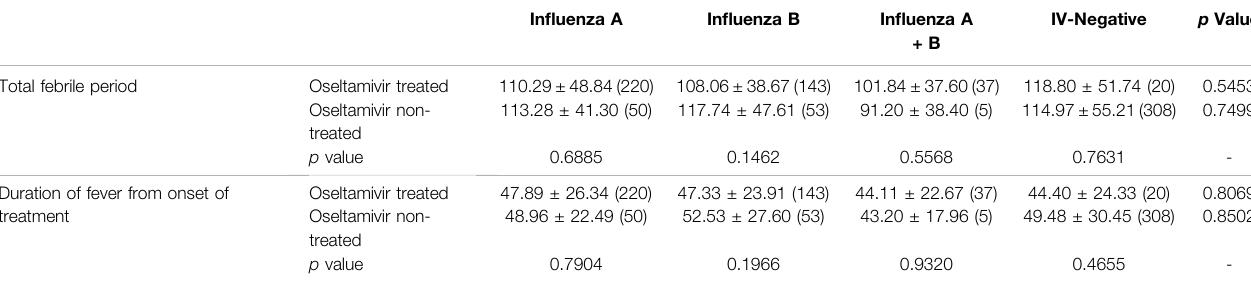
TABLE 2 | Comparison for the duration of fever of oseltamivir treated and non-treated children infected with different subtypes of in fl